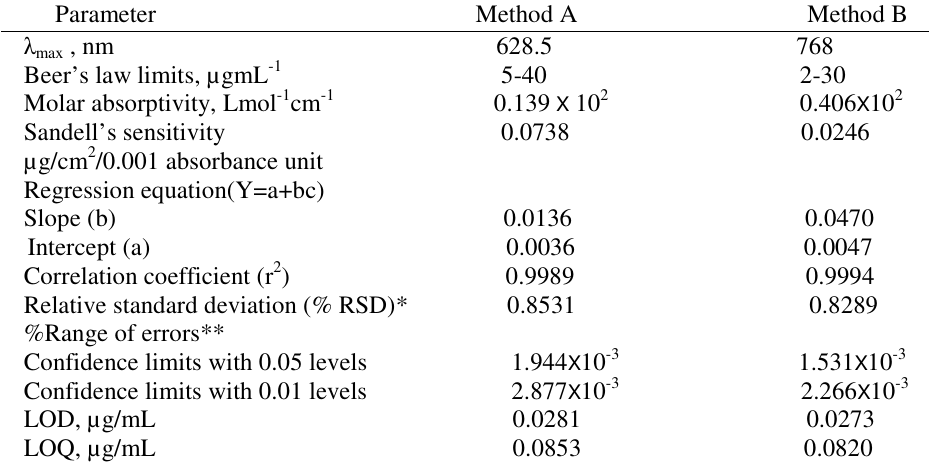
Table 1. Optical and regression characteristic, precision and accuracy of the proposed method for